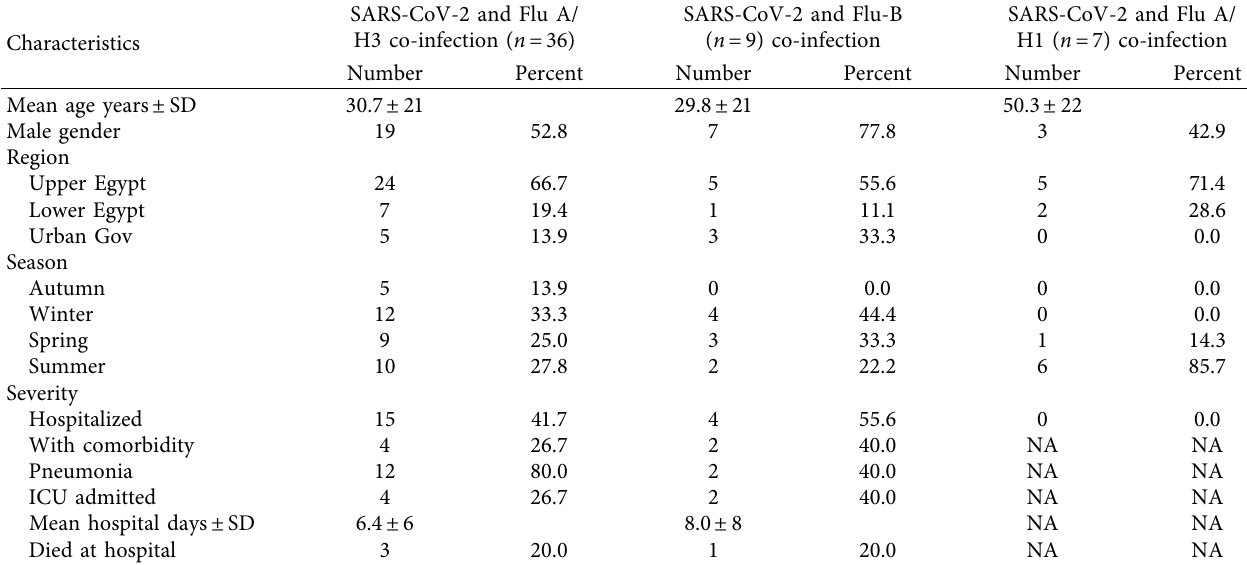
Figure 1: Montlthy distribution of COVID-19 and SARS-CoV-2/infuenza co-infection, Egypt integrated acute respiratory surveillance, 2020–2022. Table 2: A comparison of epidemiology, severity and outcome of SARS-CoV-2 and infuenza co-infection patients by infuenza subtype, Egypt integrated acute respiratory surveillance,